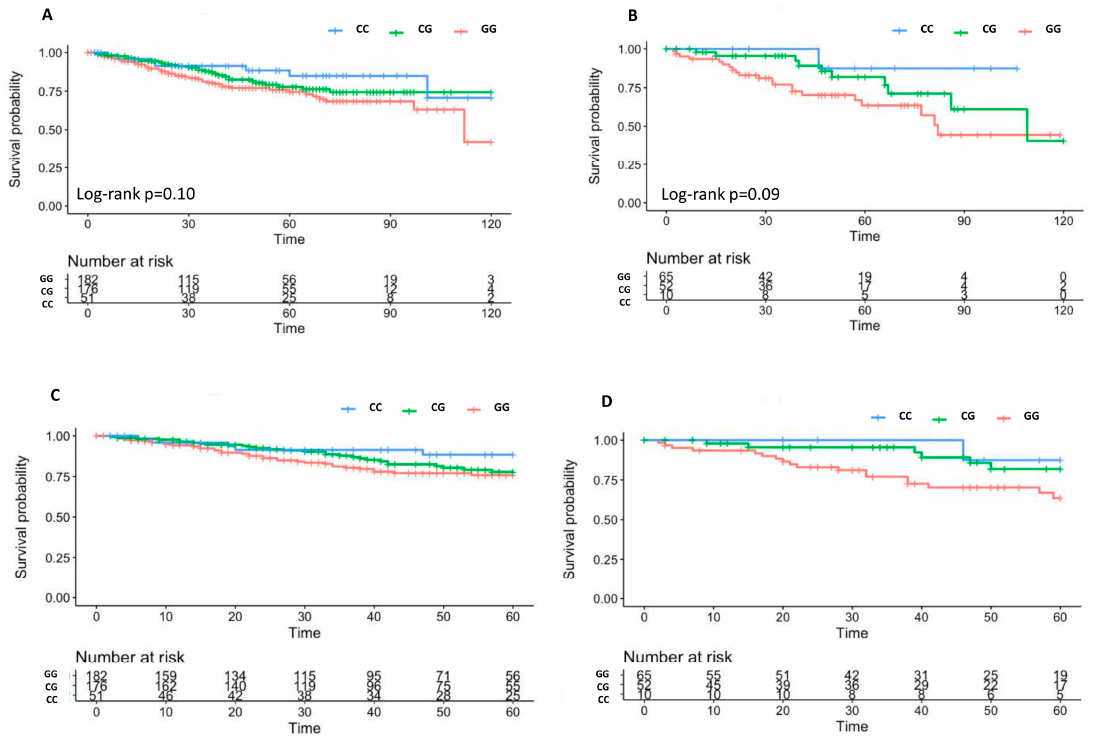
Figure 1. Kaplan–Meier curves of 10 year BCR according to rs4143815- PDL1 in the training set ( A ) and in the replication set ( B ) and Kaplan–Meier curves of 5 year BCR after RT according to rs4143815- PDL1 in the training set ( C ) and in the replication set ( D ).